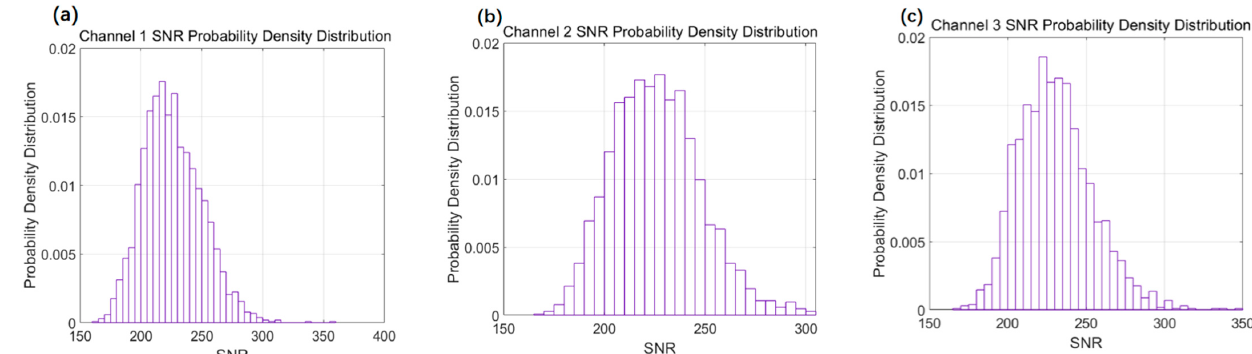
Figure 22. SNR after spatial dimension pixel combination( a ) Channel 1; ( b ) Channel 2; ( c ) Channel 3; ( d ) Channel 4; ( e ) Channel 5; ( f ) Channel 6.